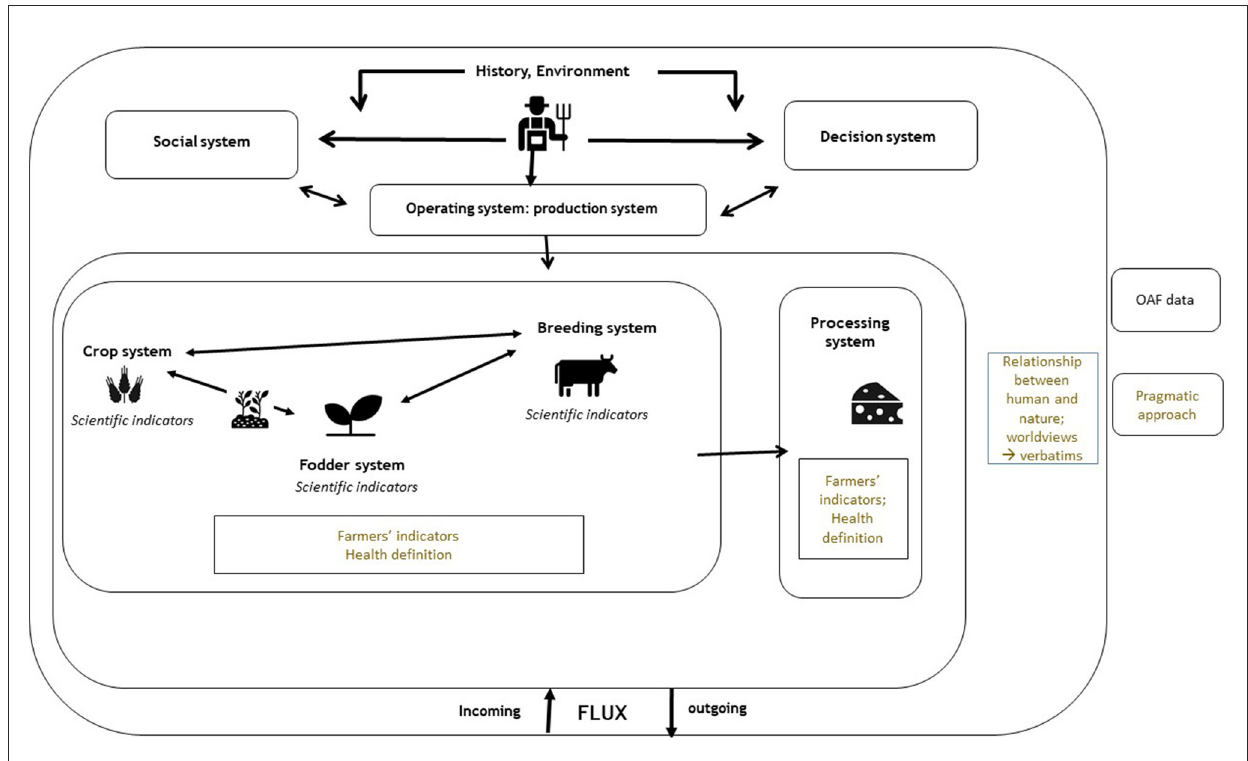
FIGURE1 Methodology combining Overall Approach to Farming and pragmatism